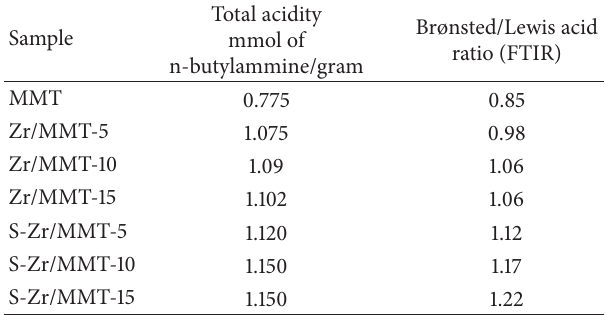
Table 3: Total acidity and B / L ratio of